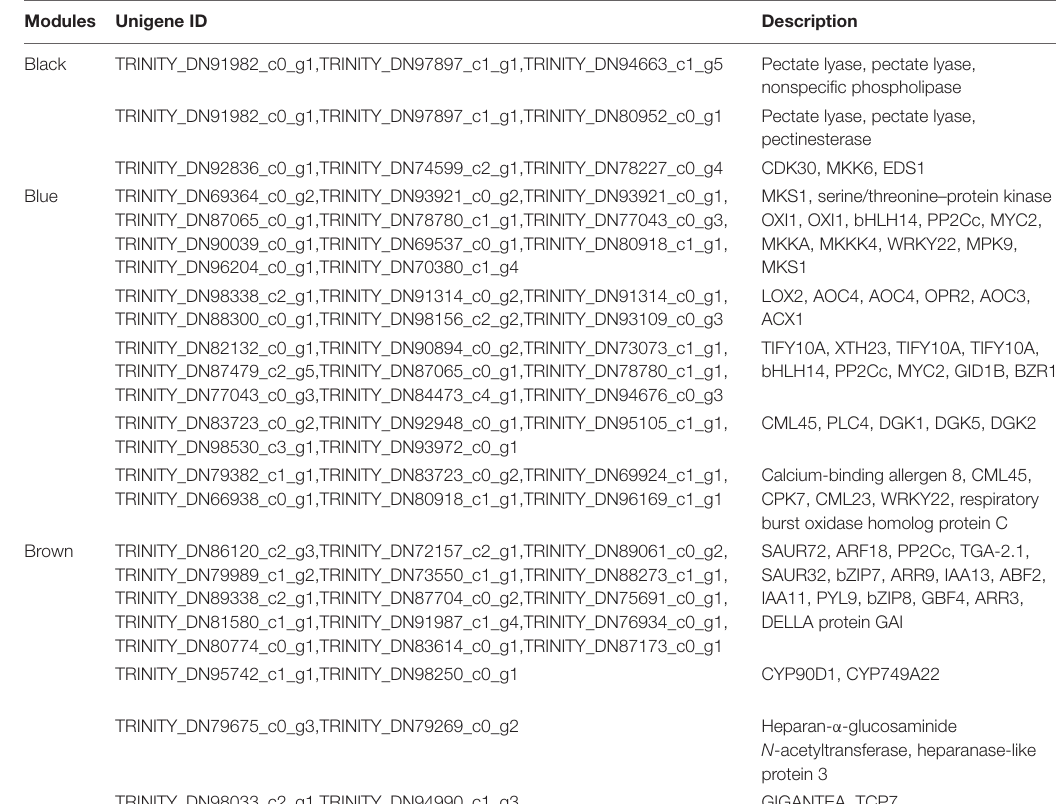
TABLE 2 | The significantly differential genes of the Kyoto Encyclopedia of Genes and Genomes (KEGG) enrichment in seven modules. Modules Unigene